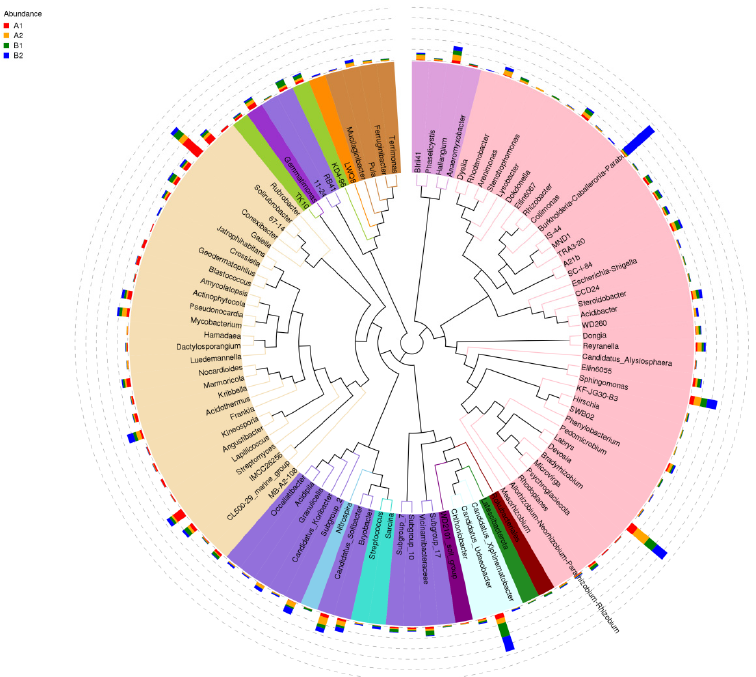
Figure 3. The evolutionary tree at genus level (A1, thermophilic of Harmanli site; A2, mesophilic of Harmanli site; B1, mesophilic of Yasno pole site; B2, thermophilic of Yasno pole site).